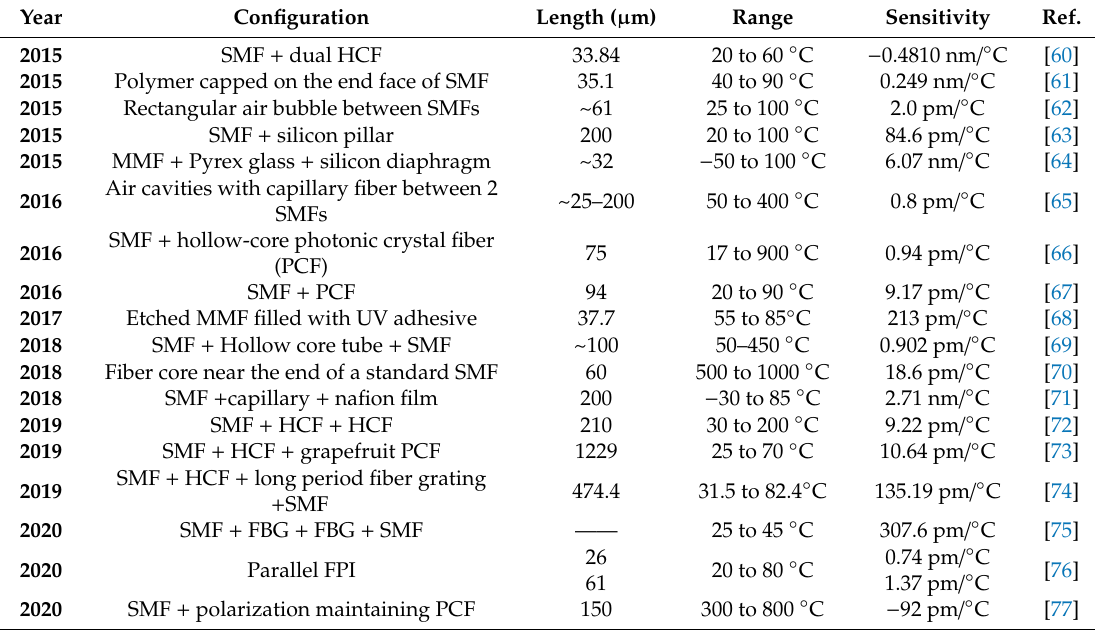
Table 1. Di ff erent configurations of Fabry-Perot sensors reported from 2015 to